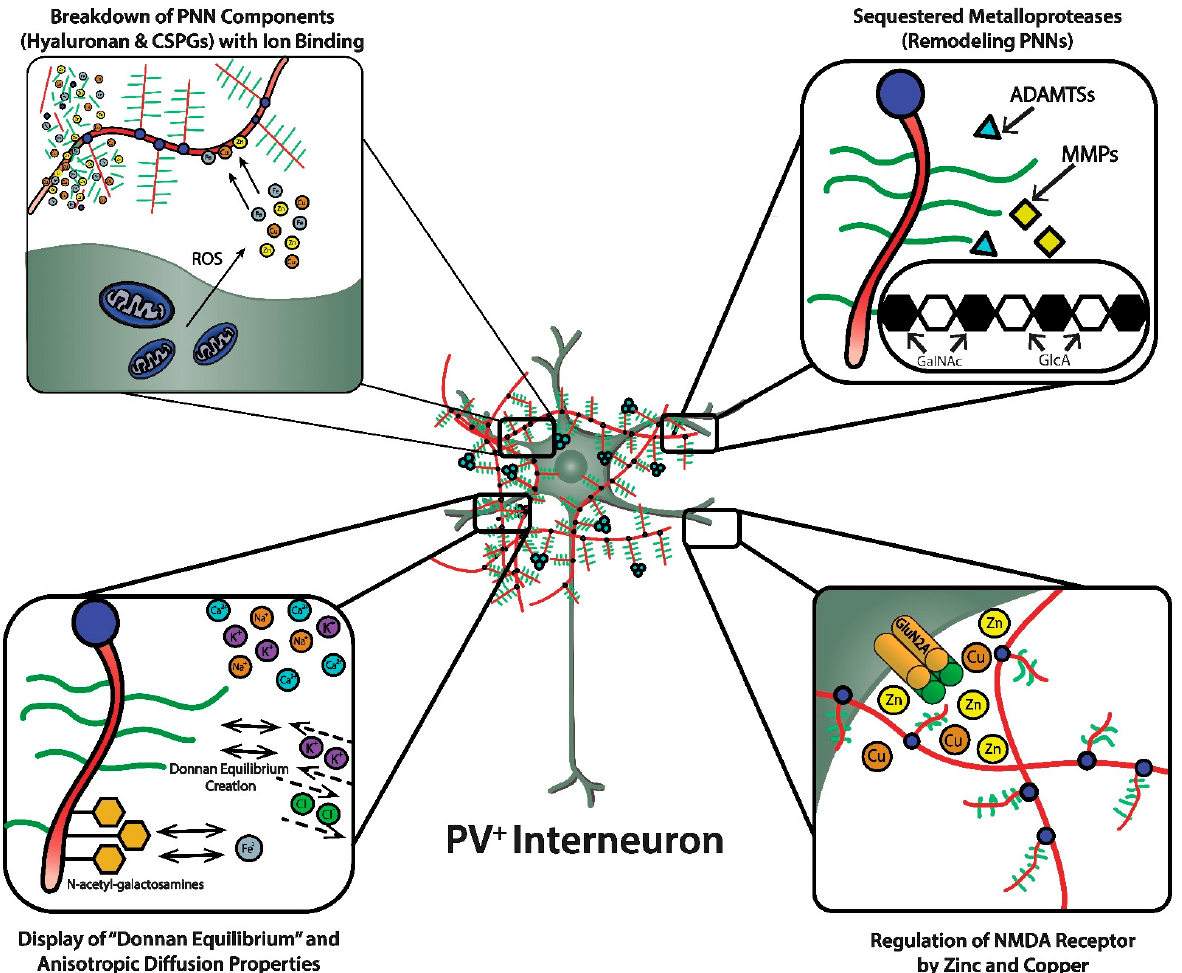
Figure 3. Functional roles of perineuronal nets (PNNs).